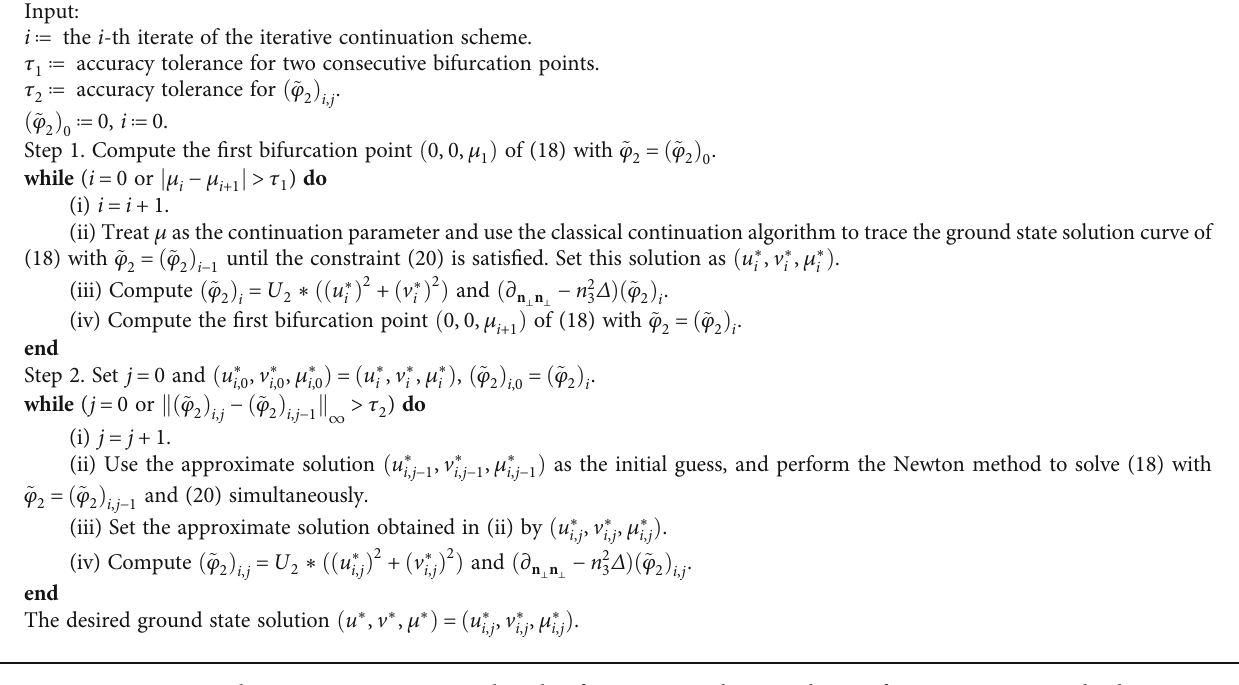
Algorithm 1: A single-parameter continuation algorithm for computing the ground state of a quasi-2D rotating dipolar